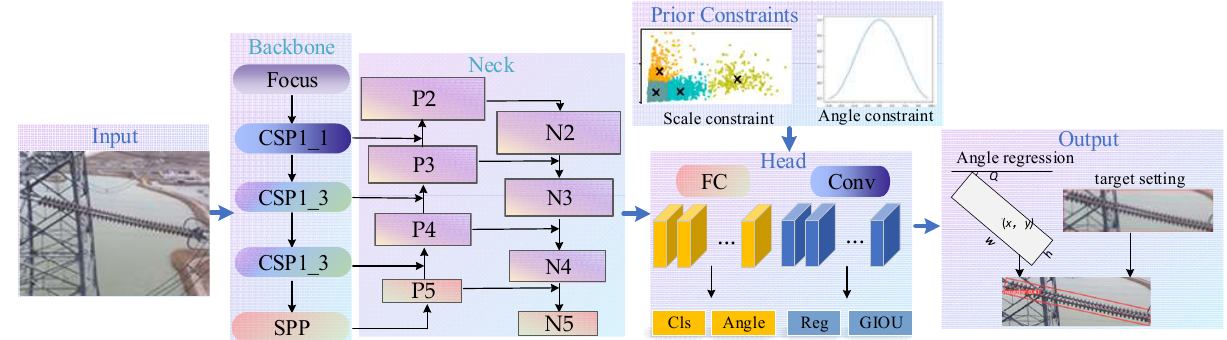
Figure 1. Architecture of RAPC-YOLO.